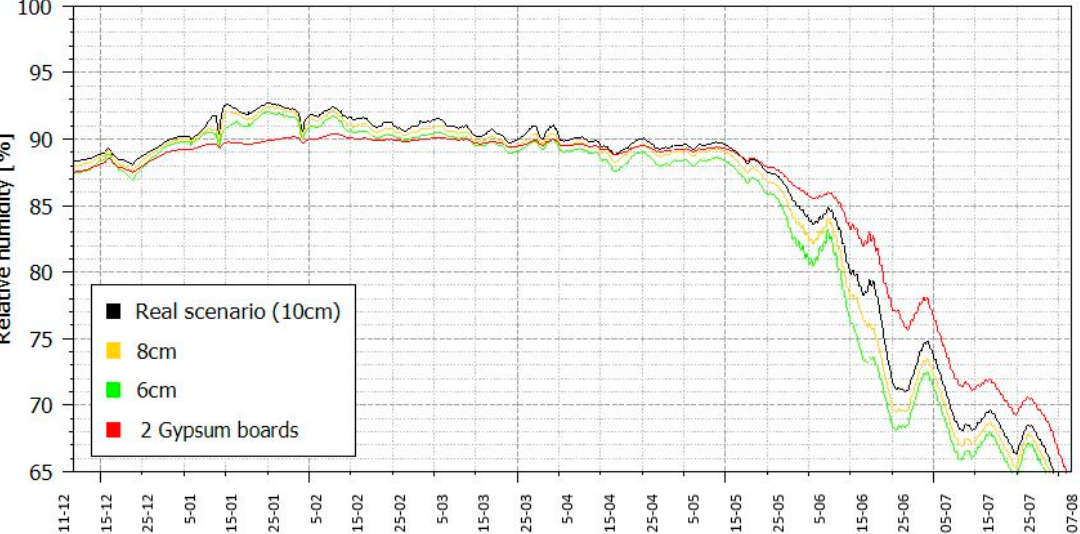
Figure 17. RH in point C (Figure 9) during the period 11 December–7 August, for the simulated wall. Design scenarios of 6–8 cm of stone wool and 2 gypsum boards as interior finishing are included.